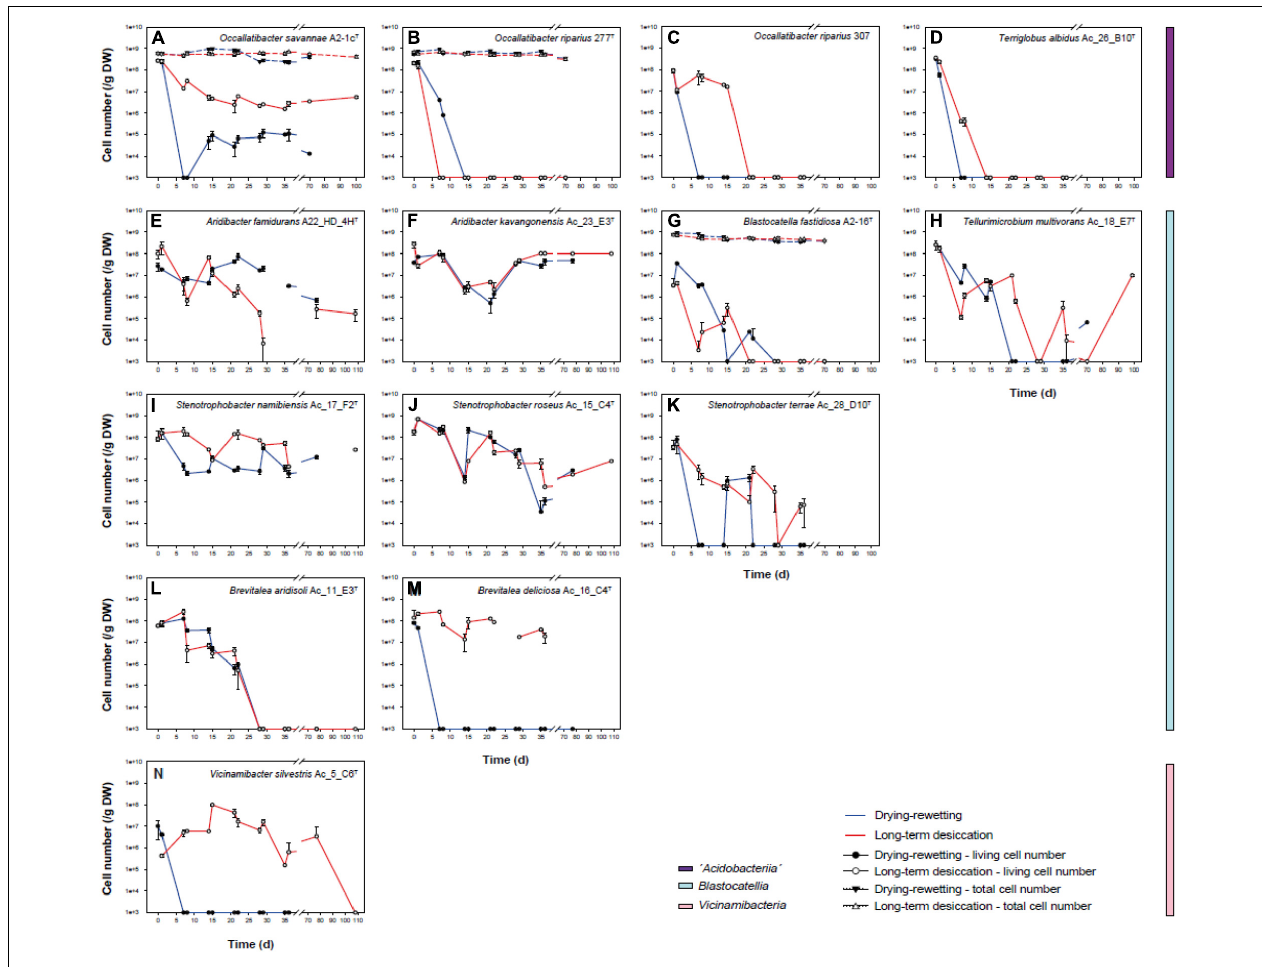
FIGURE 7 | Colony forming units of long-term drying-rewetting (filled circles) and the continuous desiccation experiments (empty circles) with Occallatibacter savannae A2-1c T (A) , O. riparius 277 T (B) and 307 (C) , Terriglobus albidus Ac_26_B10 T (D) , Aridibacter famidurans A22_HD_4H T (E) , A. kavangonensis Ac_23_E3 T (F) , Blastocatella fastidiosa A2-16 T (G) , Tellurimicrobium multivorans Ac_18_E7 T (H) , Stenotrophobacter namibiensis Ac_17_F2 T (I) , S. roseus Ac_15_C4 T (J) , S. terrae Ac_28_D10 T (K) , Brevitalea aridisoli Ac_11_E3 T (L) , B. deliciosa Ac_16_C4 T (M) , and Vicinamibacter silvestris Ac_5_C6 T (N)